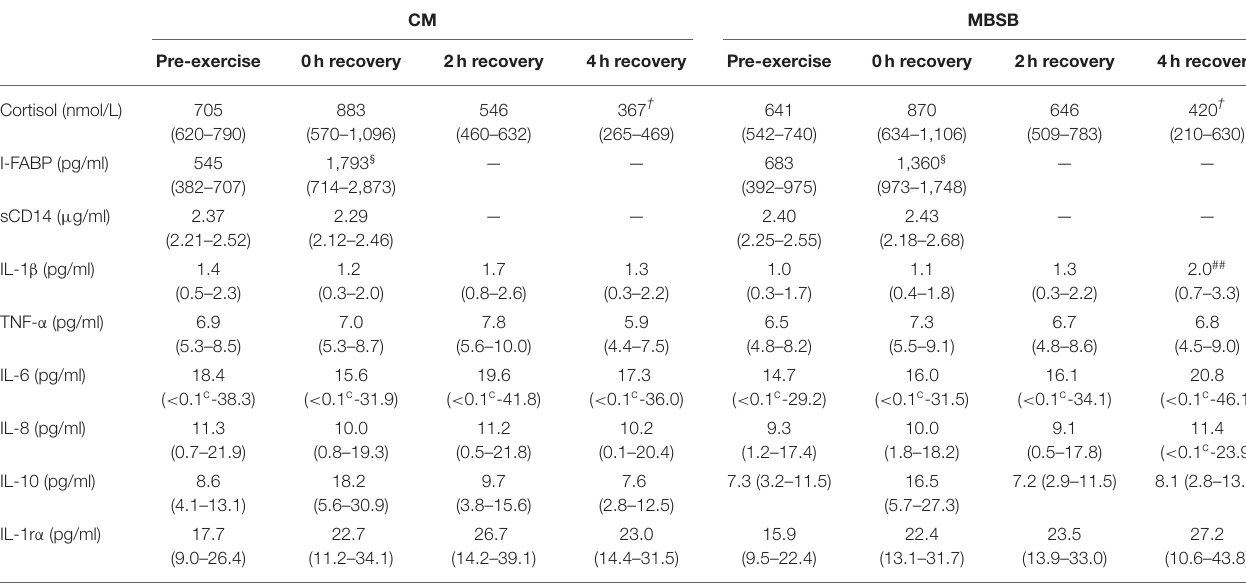
TABLE 1 | Change in gastrointestinal and immune biomarkers in response to 2h HIIT exercise (between 60 and 80% V O 2max ) in temperate ambient conditions and after consumption of a whole food dairy milk beverage (CM) and a reconstituted milk based supplement beverage